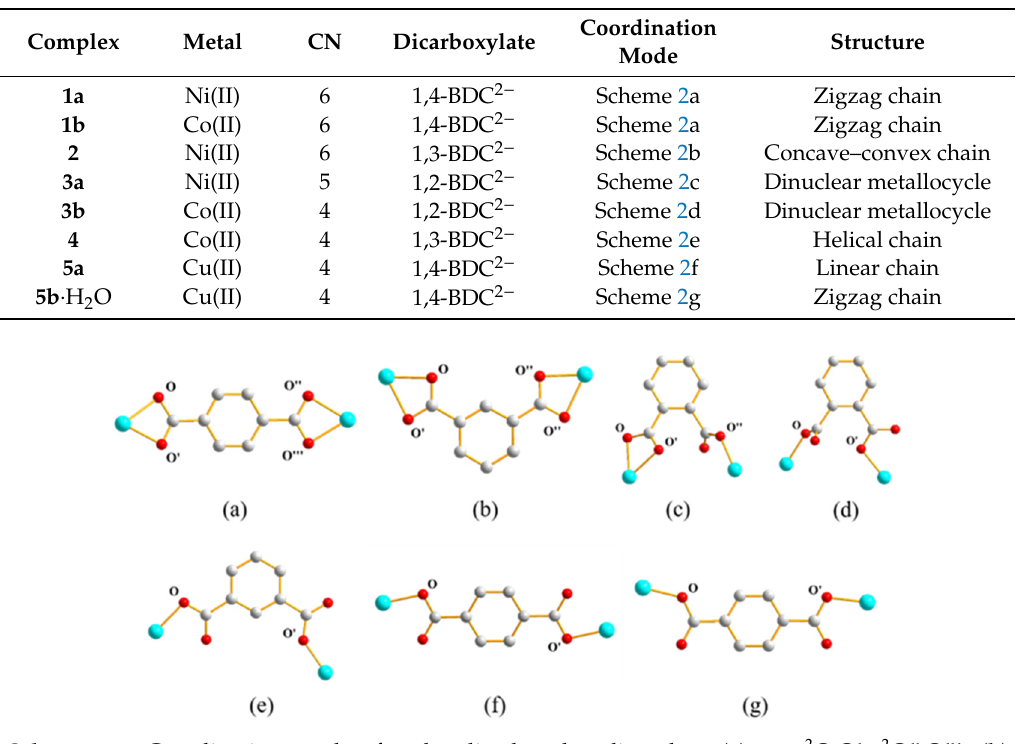
Table 2. Structural parameters of 1 – 5